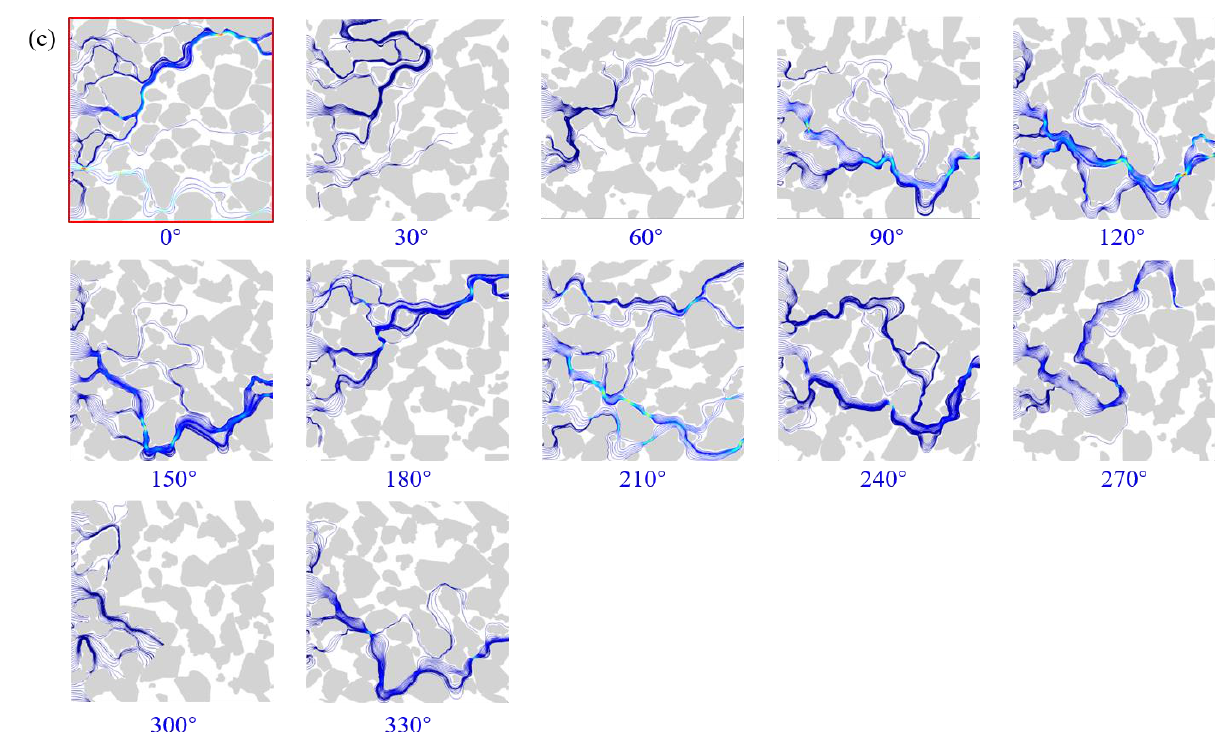
Figure 16. Influence of grain orientation on permeability. ( a ) Pore models with different grain orientations; ( b ) porosity and permeability of pore models with different grain orientations; ( c ) flow paths and velocity of pore models with different grain orientations.